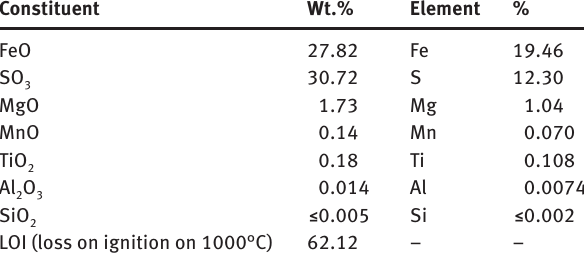
Table 1: Chemical composition of ferrous sulfate